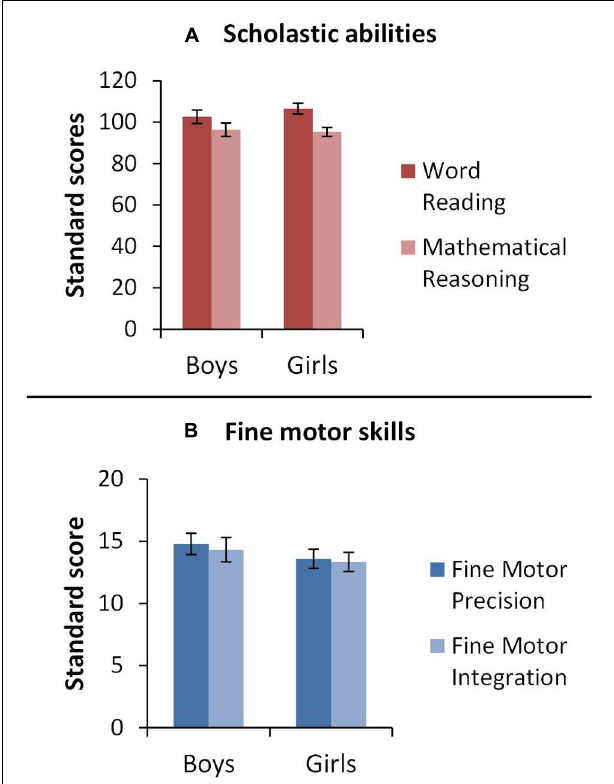
FIGURE 1 | Study 1. Bar graph representing mean performance (standard score, y -axis) for boys and girls ( x -axis) for (A) scholastic skills and (B) fine motor skills. Error bars represent 1 standard